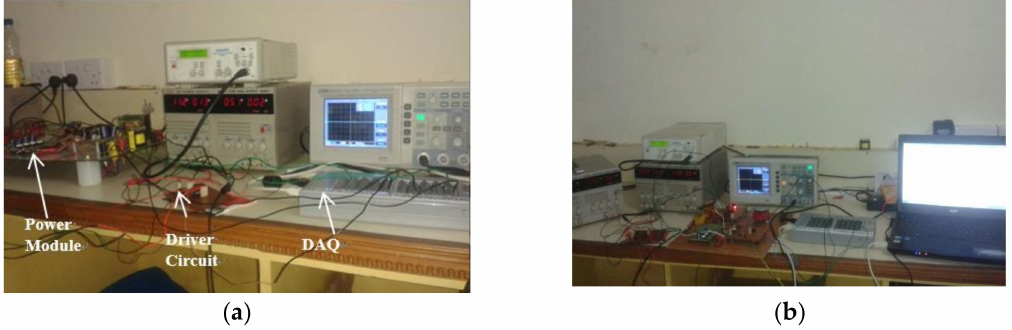
Figure 5. Laboratory setup ( a ) SIDO ( b )